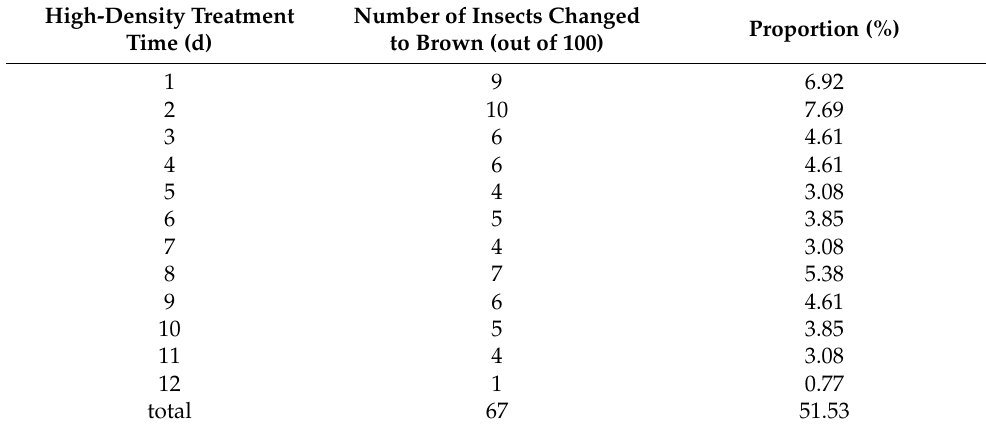
Table 1. Number and proportion of locust gregarious 12-day phenotype variation statistics. High-Density